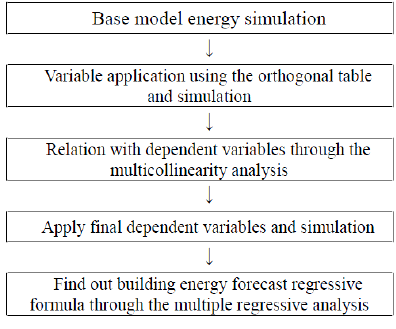
Figure 2. Statistical approach process.